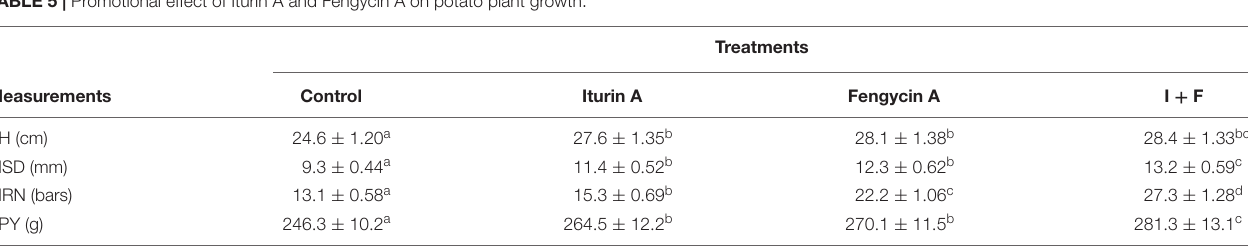
TABLE 5 | Promotional effect of Iturin A and Fengycin A on potato plant growth.